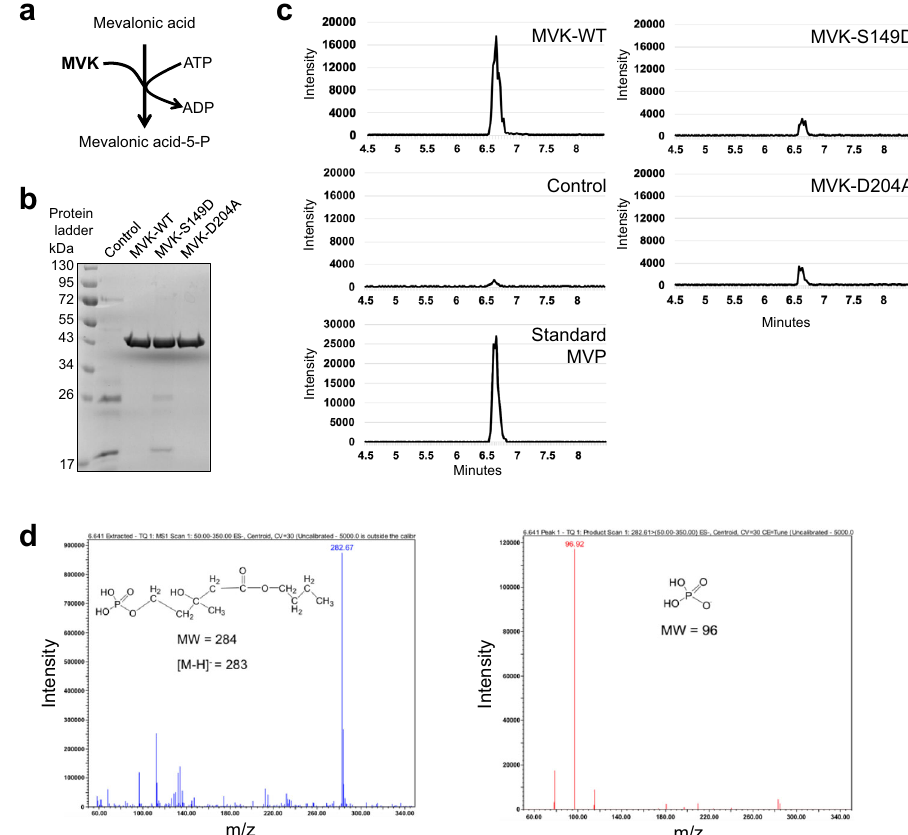
Fig. 2 Enzymatic activities of recombinant mevalonate kinase (MVK), and identi fi cation of reaction products. a Schematic representation of the conversion of mevalonic acid (MVA) into mevalonic acid-5-phosphate (MVP) (consuming ATP). b SDS-PAGE gel showing His-tag puri fi ed proteins expressed in E . coli cells expressing His-tagged MVK-WT, and two dead-versions of MVK (MVK-S149D, and MVK-D204A). As control, proteins were puri fi ed from cells carrying empty vector. The protein was measured by Coomassie brilliant blue staining. Experiment was repeated three times with similar results. c The ion chromatogram of MVP butyl ester in the samples (MVK-WT, control, MVK-S149D, MVK-D204A, and Standard MVP) quanti fi ed by LC-MS/MS analysis (m/z 283 → 96). MVP + MVK-WT peak (~6.6min) is detected in MVK reaction but not in control (empty vector control cells), and dead-versions of MVK. d The ion spectra of the molecular ion (m/z 283) (left) and product ions (right) for the analysis of the MVP butyl ester ionized in negative ion mode (ES −